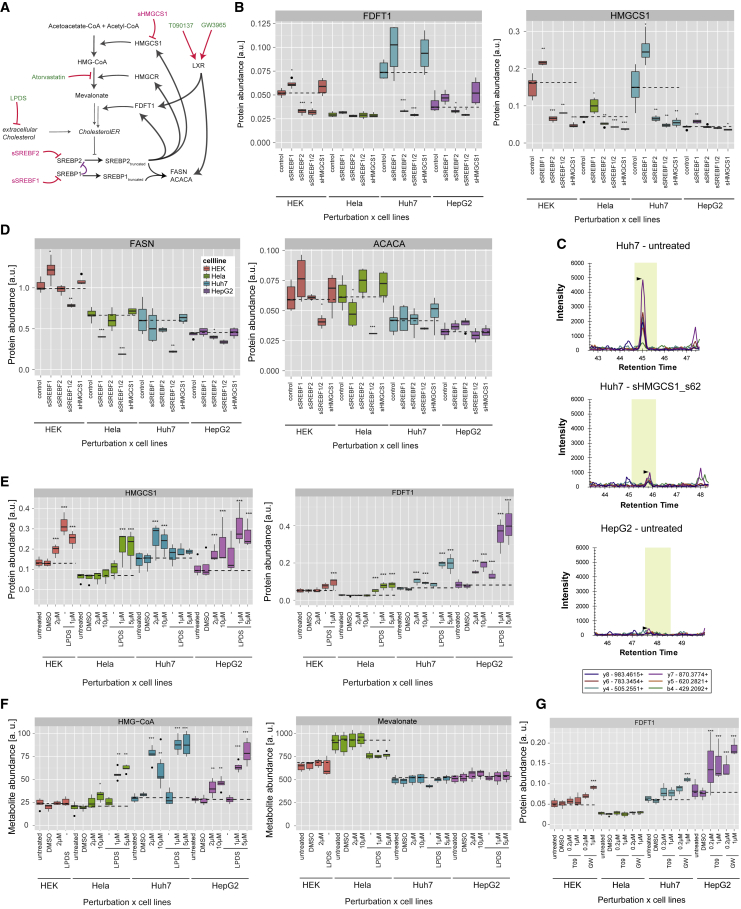
Core Regulatory Mechanisms(A) Core regulatory mechanisms relevant for this figure. Depicted in violet is a hypothetical inhibitory interaction between SREBP1 and SREBP2.(B and D) Protein abundance upon knock down of key regulators. Significance of differential expression was tested by combining the measurements for the different siRNAs and using an unpaired t test. n = 2–6; ∗p < 0.1, ∗∗p < 0.05, ∗∗∗p < 0.01.(C) Signal extracted for different fragments of the NNLSYDC[+57]IGR peptide from HMGCS1 with the software Skyline (MacLean et al., 2010). The yellow area shows the predicted retention time, and the black arrowheads indicate the peak.(E) Abundance of HMGCS1 and FDFT1 upon drug treatment.(F) Metabolite levels for HMG-CoA and mevalonate upon drug treatment.(G) Protein levels of FDFT1 upon activation of LXR.(E–G) Significant differential expression was reached with |log2FC| > 0.5 and adjusted ∗p < 0.1, ∗∗p < 0.01, ∗∗∗p < 0.001 compared with control samples. For other regulated pathways, see Figures S4 and S5.